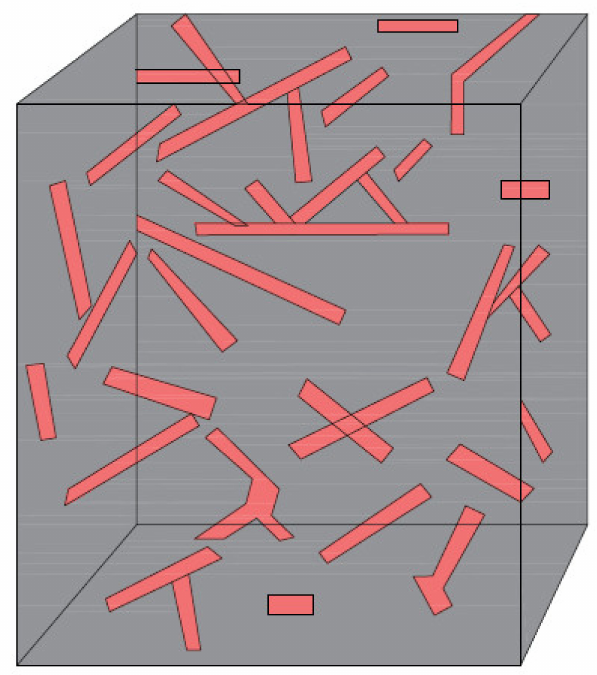
Figure 2. Illustration of a randomly oriented composite